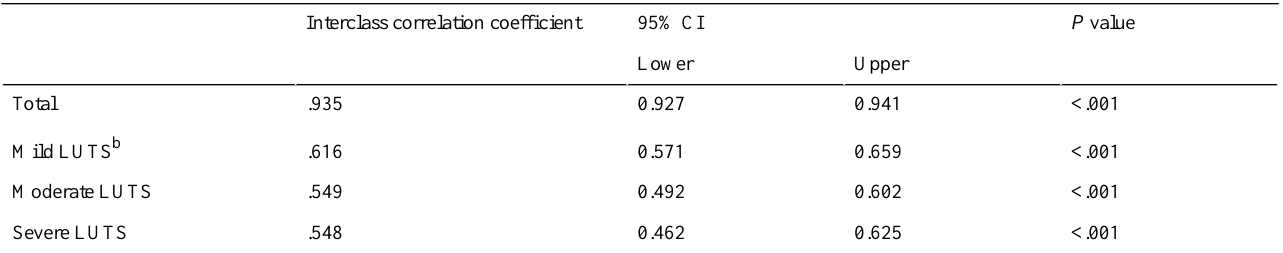
Table 6. Reliability test of paper and smartphone versions of the IPSS a